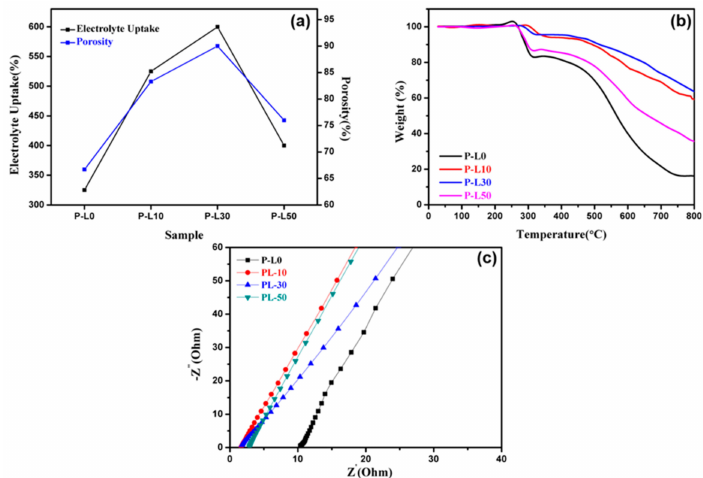
Figure 4. ( a ) Porosity and electrolyte uptake; ( b ) Thermogravimetric Analysis (TGA); and ( c ) Nyquist impedance plot of PL